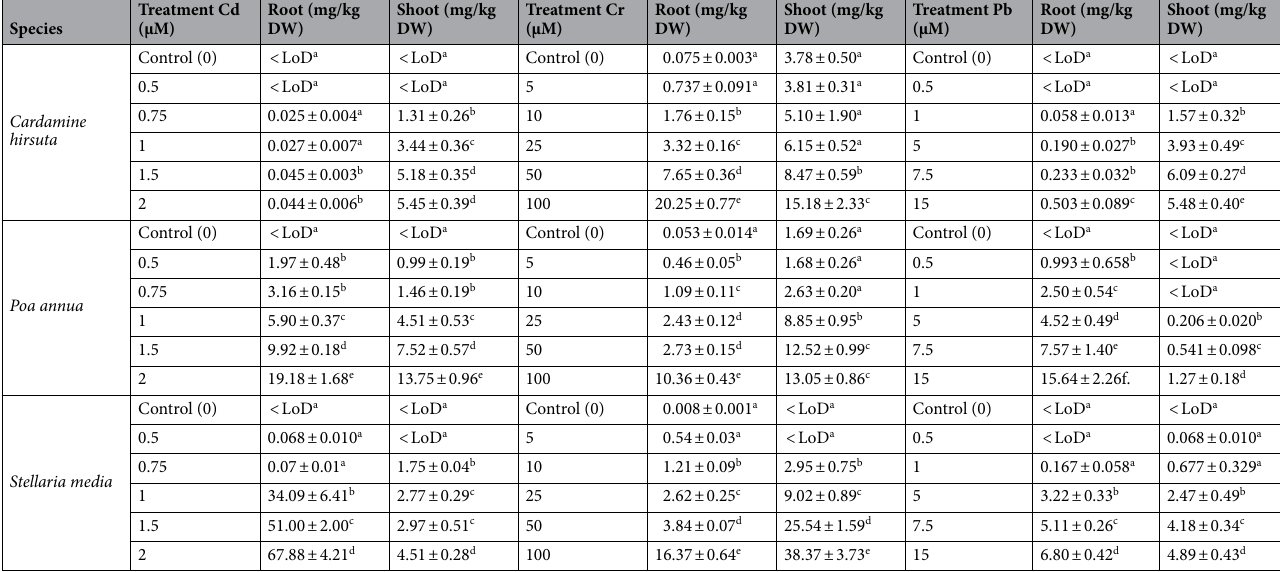
Table 1. Metal accumulation (mg / kg DW) in roots and shoots of the three tested species. Each value is the average of 5 biological replicates (n = 5) ± S.D (see detailed data met_root and met_shoot in Supplementary Tables 1–3). LoD, Limit of detection. Different letters indicate differences among groups after one-way ANOVA ( p ≤ 0.05) (Supplementary Table 4) followed by post-hoc Tukey HSD